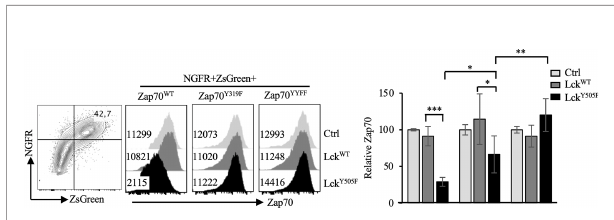
FIGURE 7 | Phosphorylation of Y315/Y319 in Zap70 is required for Lck- induced Zap70 degradation. 293T cells were co-transfected with control, Lck WT or Lck Y505F (expressing NGFR reporter) and Zap70 WT , Zap70 Y319F or Zap70 YYFF (expressing ZsGreen reporter) plasmids. Histograms show Zap70 expression in NGFR+ZsGreen+ 293T cells. Bar graph shows compilation of relative Zap70 expression in the indicated 293T transfectants from three independent experiments. *p < 0.05, **p < 0.005, ***p <